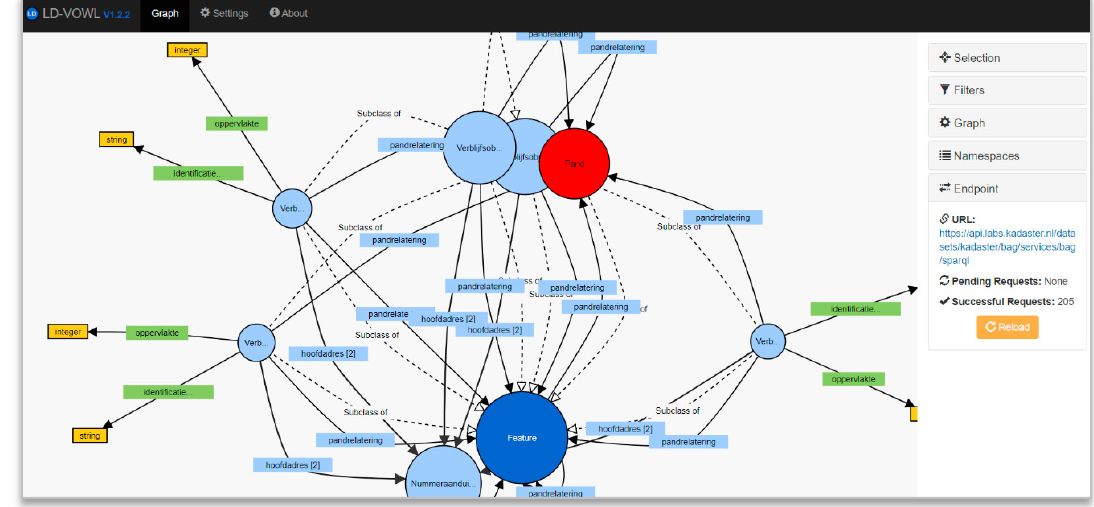
Figure 6. Example User Interface making use of Basisregistratie Adressen en Gebouwen (BAG) dataset, Kadaster. Retrieved from: